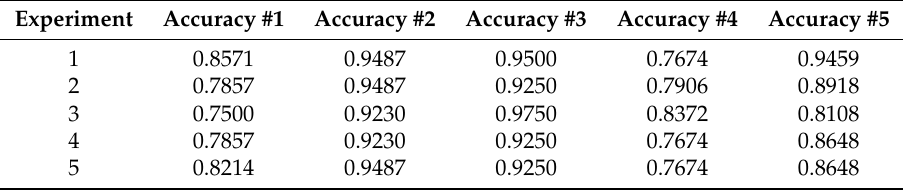
Table 2. Prediction accuracy of different categories for different experiments.